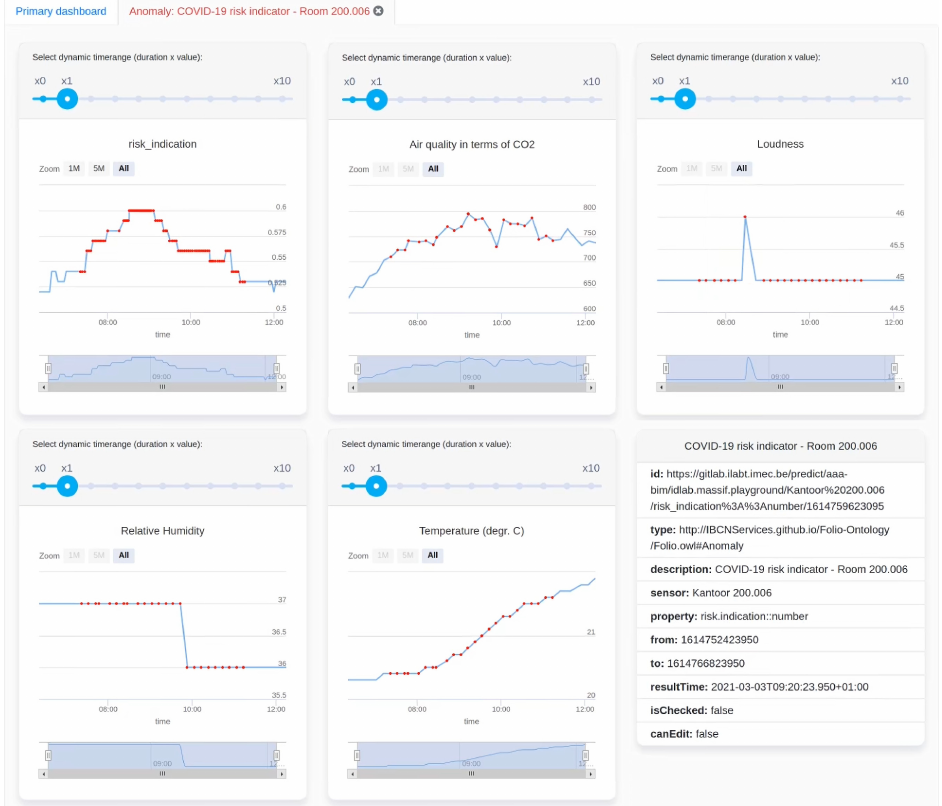
Figure 8. Dynamically constructed event view when a “High COVID-19 risk estimation” event occurs, visualizing the COVID-19 aerosol transmission risk estimation signal and linked